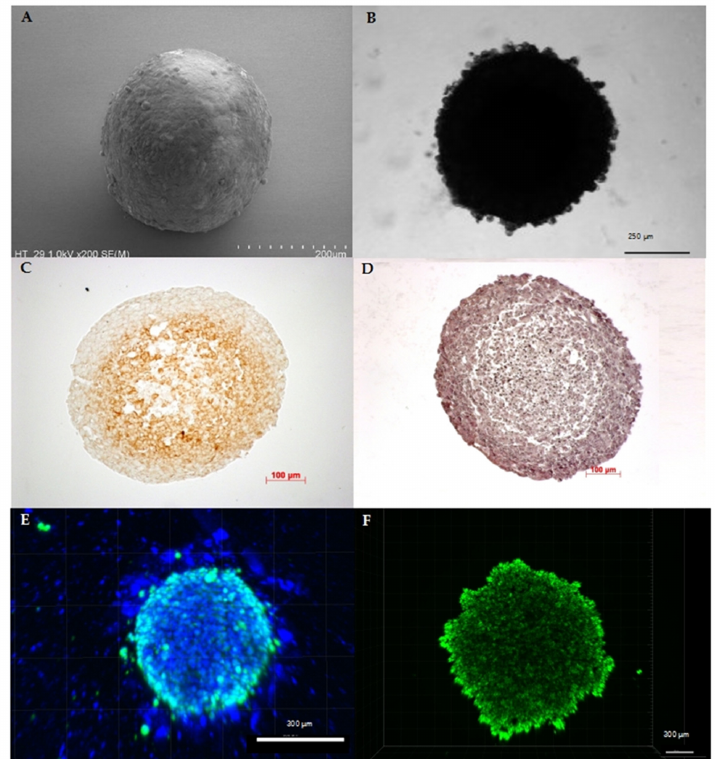
Figure 1. Characteristics of spheroids originating from human cancer cell lines: ( A ) SEM image of a colorectal cancer cell line (HT29) spheroid depicting the spherical shape as the main characteristic of spheroids. ( B ) Bright-field microscopy image of a pancreatic cancer cell line (HPAF II) spheroid confirming stability of the 3D cell assembly. ( C ) Like tumors in vivo, spheroids show physiological zoning, consisting of a rim of viable cells and, depending on their size, of hypoxic or necrotic core zone. Exemplarily, the hypoxic core of a melanoma cell line (A2508) spheroid with a diameter of approximately 0.55 mm is shown by pimonidazole staining. ( D ) Hematoxylin and eosin staining of a melanoma cell line (A2508) spheroid showing the heterogeneous composition that can vary in cell and extracellular matrix arrangement depending on cell line and treatment. ( E ) Distribution of viable cells and, as a further characteristic feature, the possible active migration of cells from the 3D cell assembly: here, exemplarily shown by fluorescence staining with DAPI (4 (cid:48) ,6-diamidino-2-phenylindole) (blue) and calcein (green) in a 10-day-old co-cultivated spheroid of pancreatic carcinoma cell line (SW1990) and pancreatic stellate cells (HPaSteC) with an initial seeded cell number of 16,000 cells (ratio 1:3). ( F ) Spheroids are characterized by the formation of gradients, which, among other things, modify the transport of nutrients, metabolites, and drugs similar to the situation in vivo, as shown here in the passive transport of the fluorescent marker calcein in a 10-day-old pancreatic cancer cell line (PanC-1) spheroid with an initial seeded cell number of 16,000